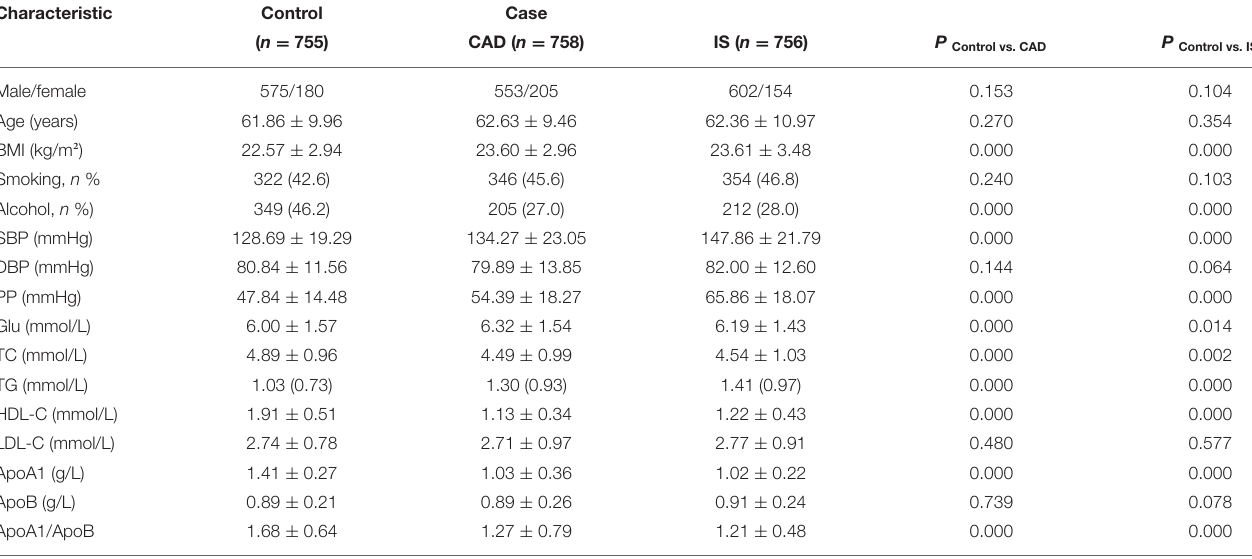
TABLE 1 | Comparison of demographic, lifestyle characteristics, and serum lipid levels of the participants.